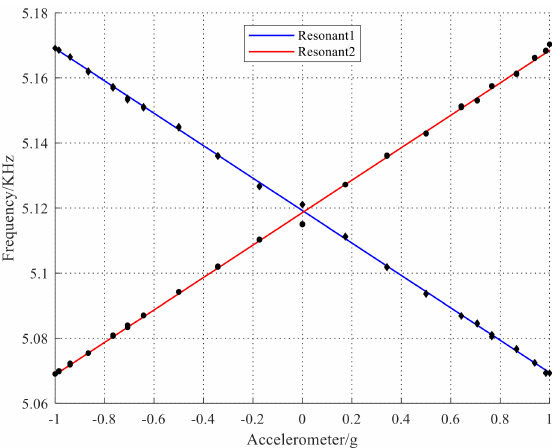
Figure 18. Acceleration frequency of two resonators.